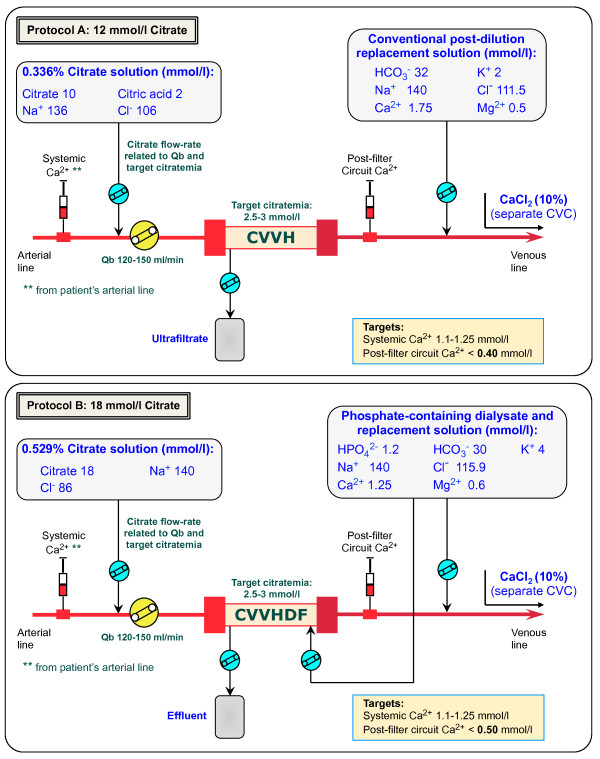
Pre-post dilution RCA-CVVH and RCA-CVVHDF circuits. Schematic representation of the RCA extracorporeal circuits reporting the composition of the solutions respectively adopted in protocol A(top panel) and protocol B(bottom panel).